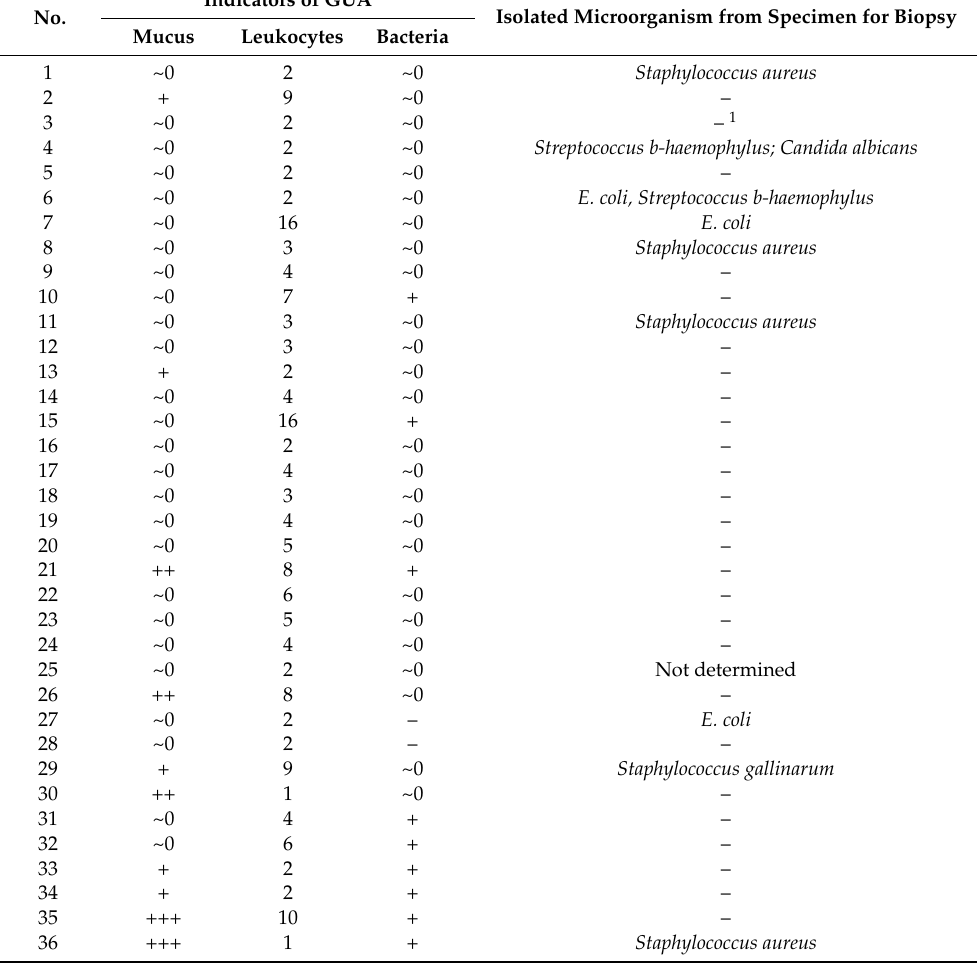
Table 1. Some indicators of general urine analysis (GUA) of patients and results of bacteriological investigation of biomaterial after